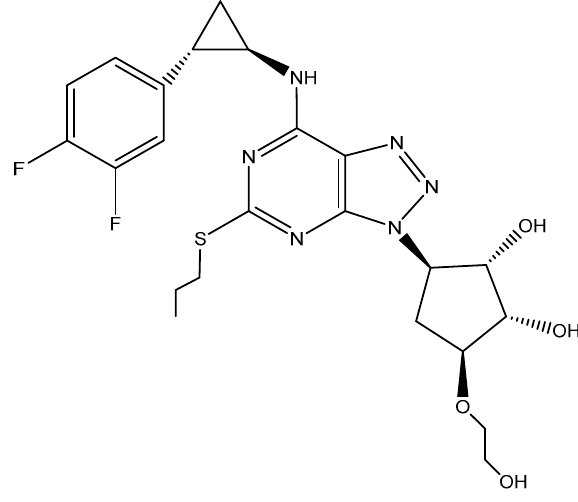
Figure 1. The chemical diagram of TICA.